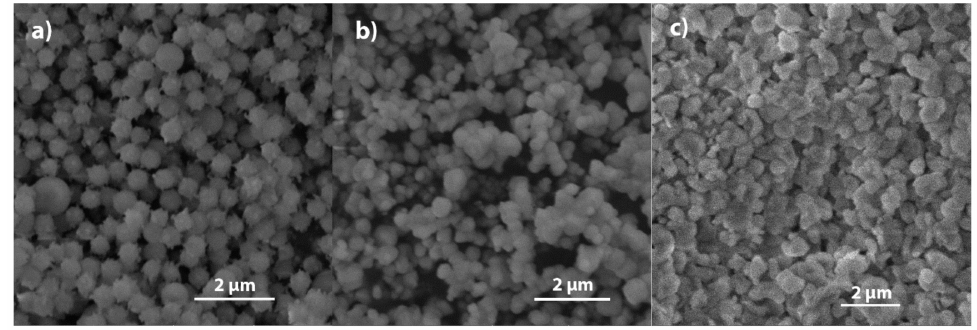
Figure 4. Scanning electron microscopy: ( a ) SH-0.33-0.2; ( b ) Me-0.33-0.14; ( c )